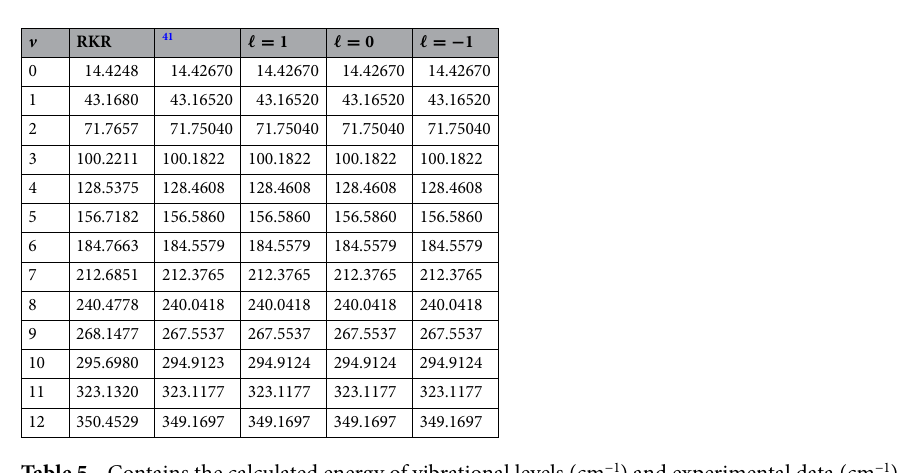
Table 5. Contains the calculated energy of vibrational levels (cm −1 ) and experimental data (cm −1 ) of cesium dimer for the modified shifted Morse and Morse potential